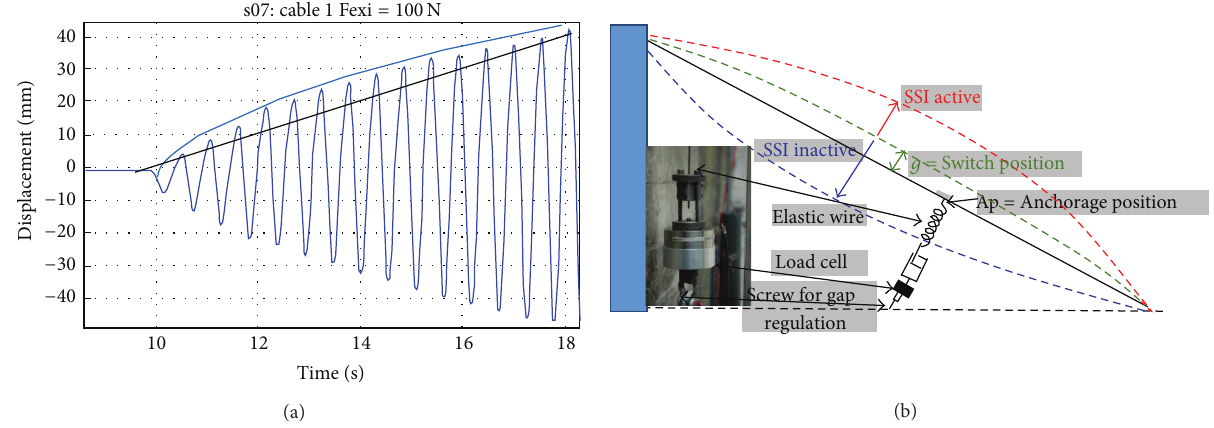
Figure 1: (a) Cable resonance with low damping (blue curve fitting); (b) SSI